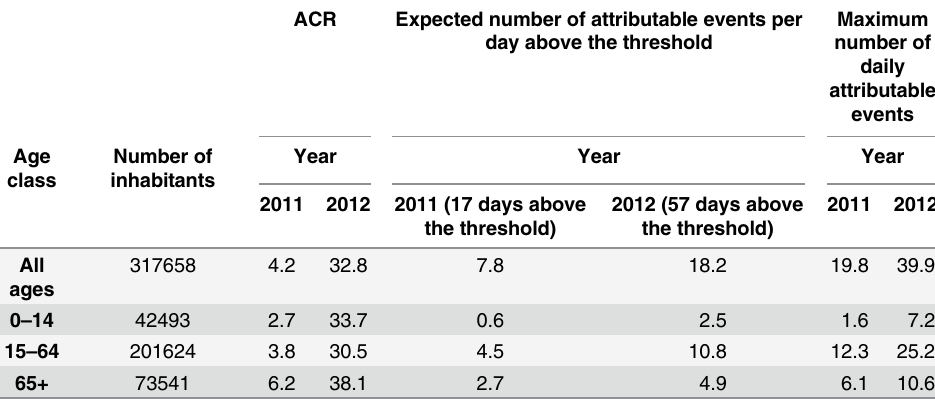
Table 4. Attributable community rates by year, expected number of attributable no-white tag visits per day with apparent temperature above the threshold and maximum daily number of attributable no-white tag visits. ACR Expected number of attributable events per day above the threshold